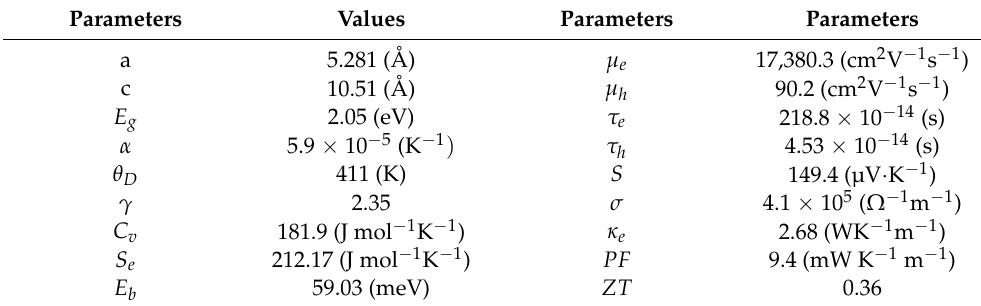
Table 1. The computed lattice parameters (a, c), band gap energy ( E g ), Debye temperature ( θ D ), Grüneisen parameter ( γ ), thermal expansion coefficient ( α ), entropy ( S e ), constant-volume heat capacity ( C v ), electron mobility ( µ e ), hole mobility ( µ h ), electron relaxation time ( τ e ), hole relaxation time ( τ h ), Seebeck coefficient (S), electrical conductivity ( σ ), electron thermal conductivity ( κ e ), power factor ( PF ), figure of merit ( ZT ) and exciton binding energy ( E b ) at ambient temperature of CZGS. Whenever applied, the values are reported at room temperature. .